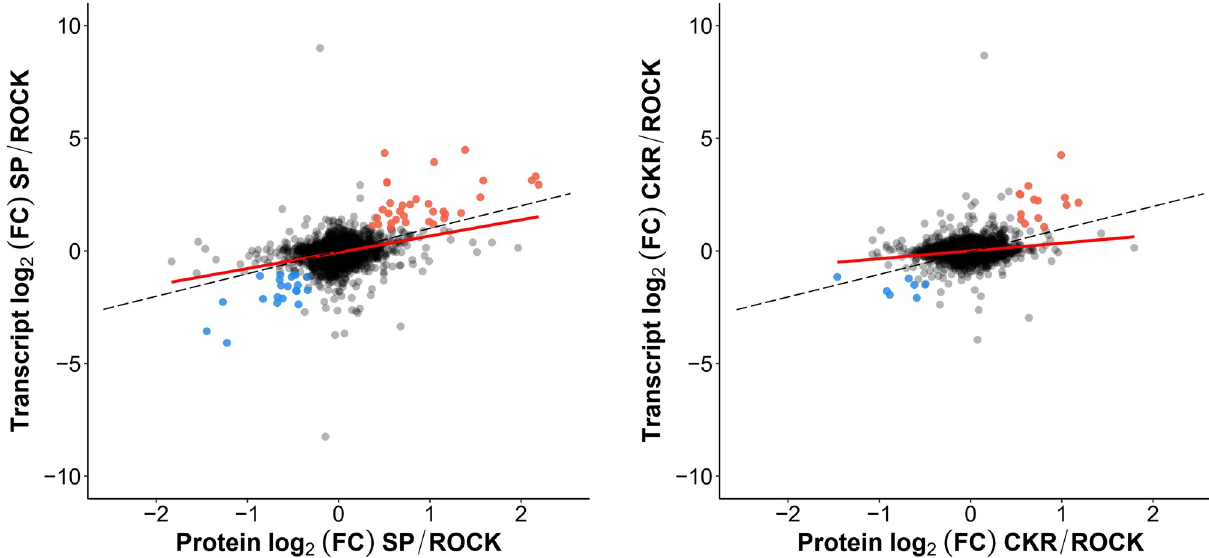
Fig 5. Correlation between all detected proteins and transcripts. A: Plot of the log 2 (FC) between all detected proteins and transcripts (red line) for SP relative to ROCK (Pearson’s correlation of 0.32). B: Plot of the log 2 (FC) between all detected proteins and transcripts for CKR relative to ROCK (Pearson’s correlation of 0.20). The dashed line represents a slope of